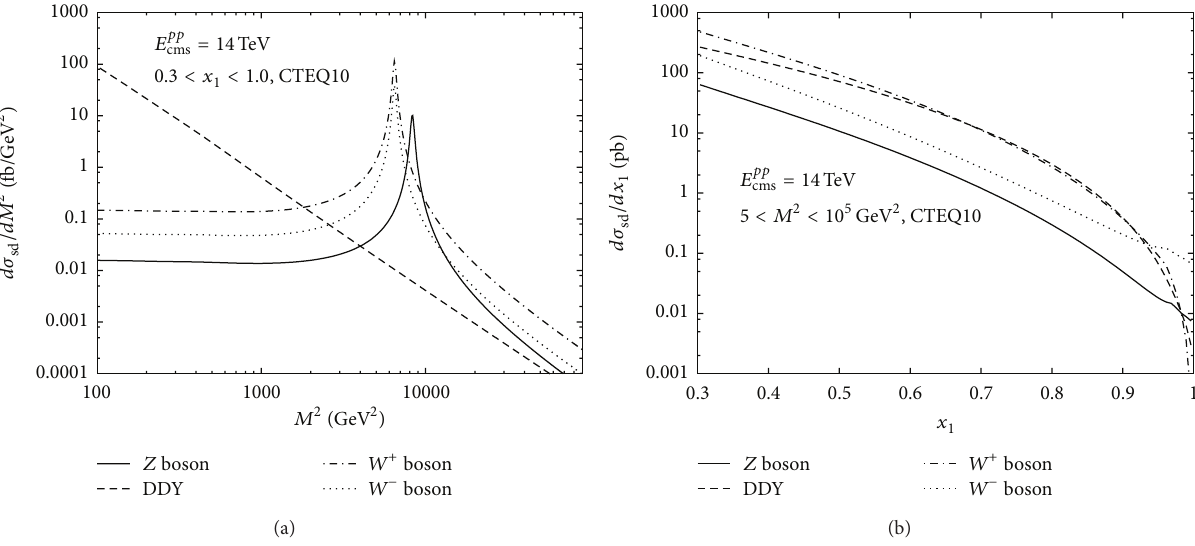
Figure 9: Diffractive gauge boson production cross section as function of invariant mass squared 𝑀 2 (a) and momentum fraction 𝑥 1 (b) at the LHC.